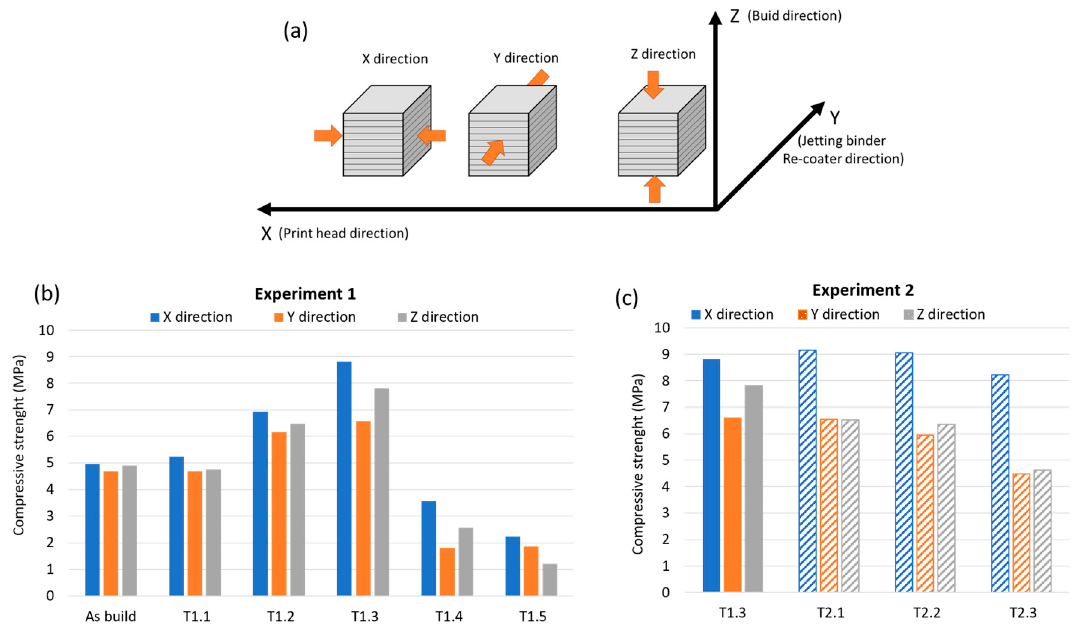
Figure 12. ( a ) Direction of compression force, ( b ) compression strength values for Experiment 1 and ( c ) compression strength values for Experiment 2.